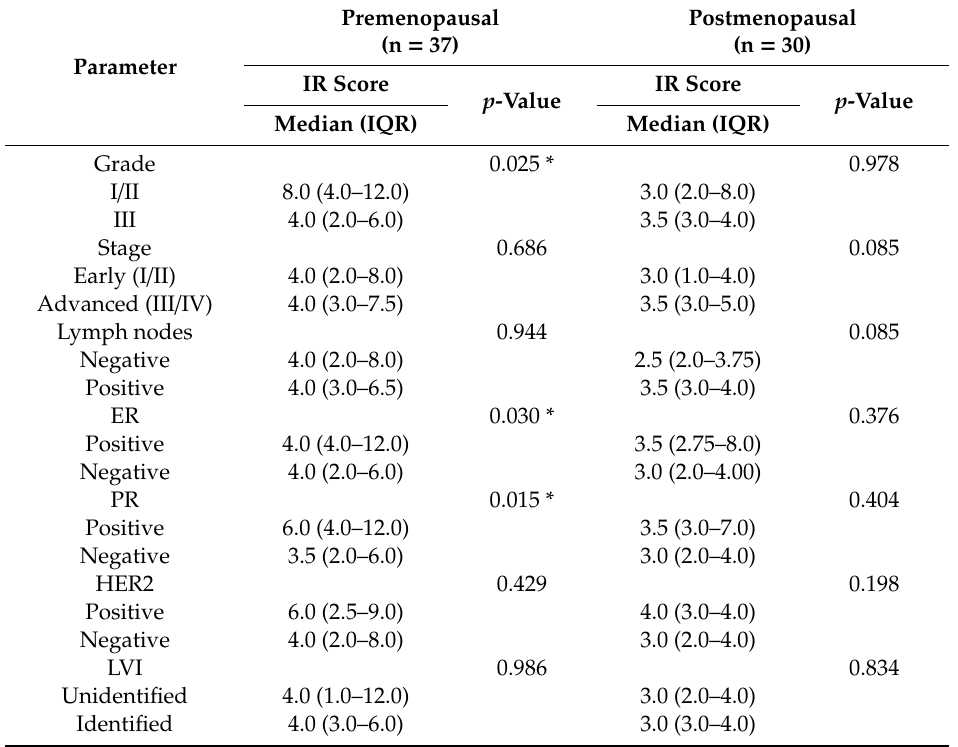
Table 5. Correlation between IR expression with clinicopathologic factors stratified by menopausal status among breast cancer patients (n = 67).